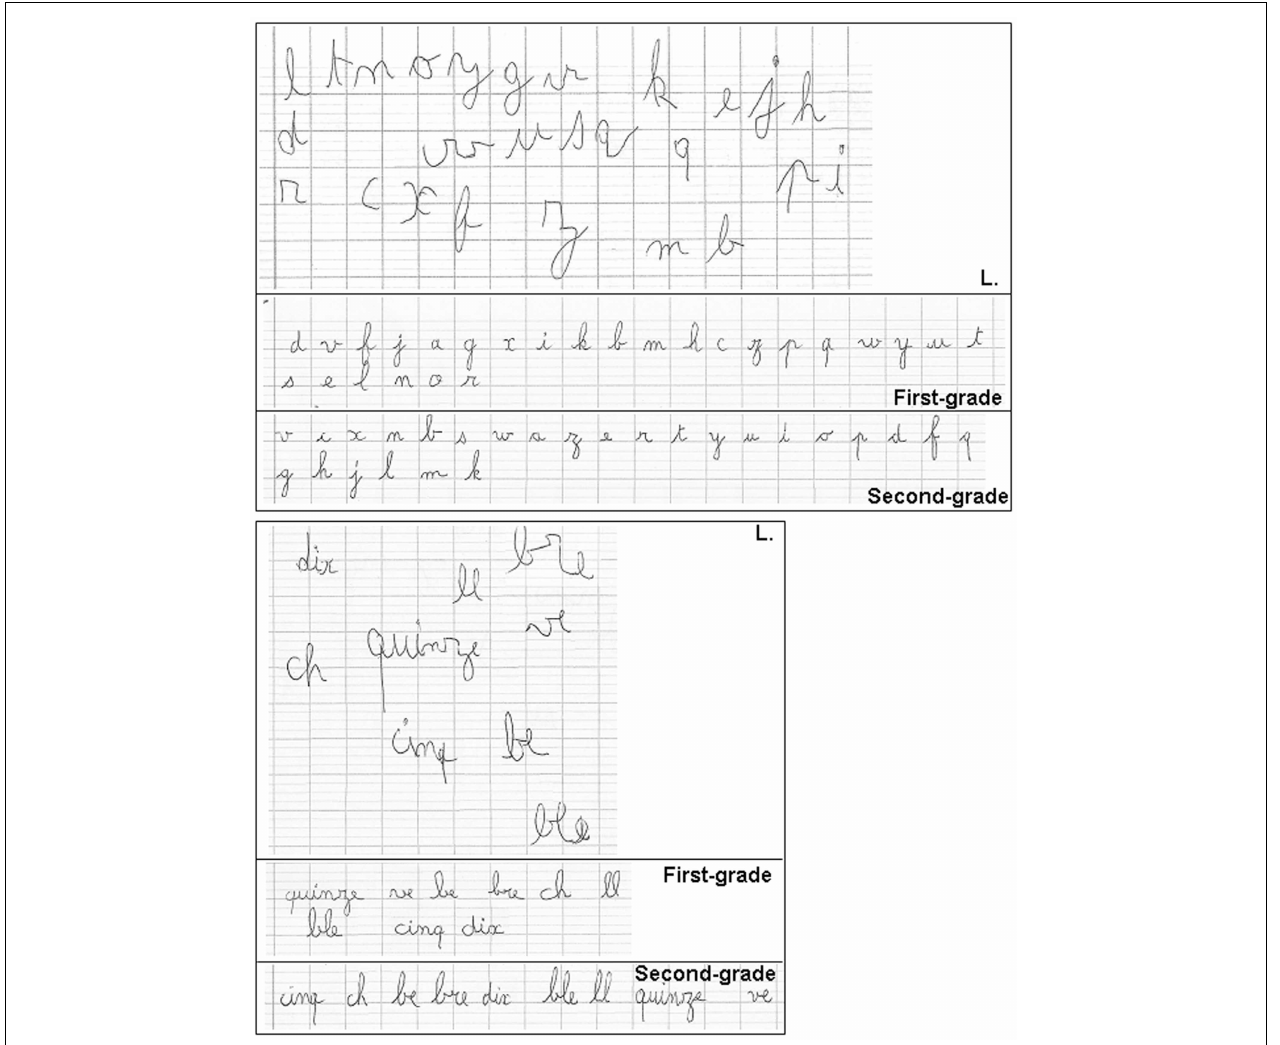
FIGURE 1 | Samples of cursive handwriting by children. Examples of dictations performed by the child with DCD, first-graders and second-graders are displayed for isolated letters ( top panel ) and syllables and words ( bottom panel